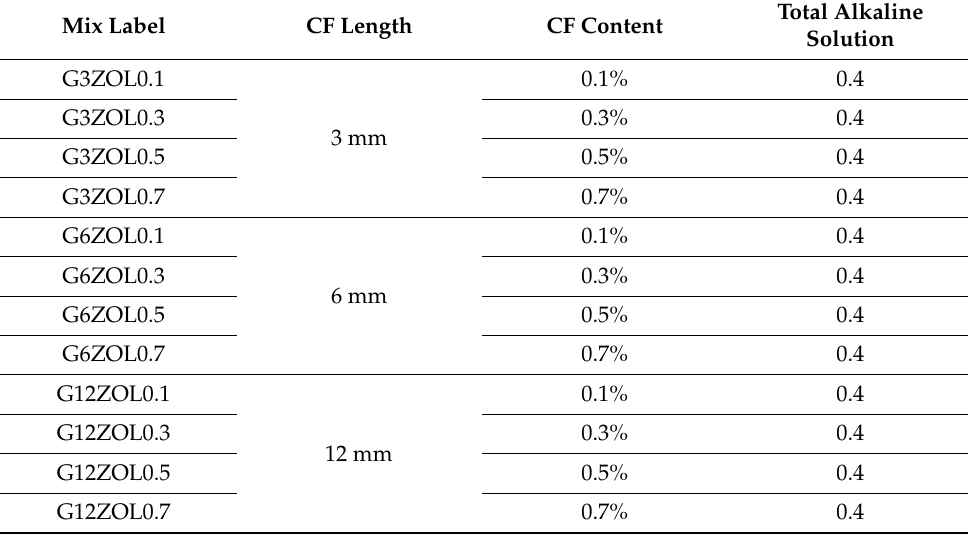
Table 5. Composition of the mixes containing